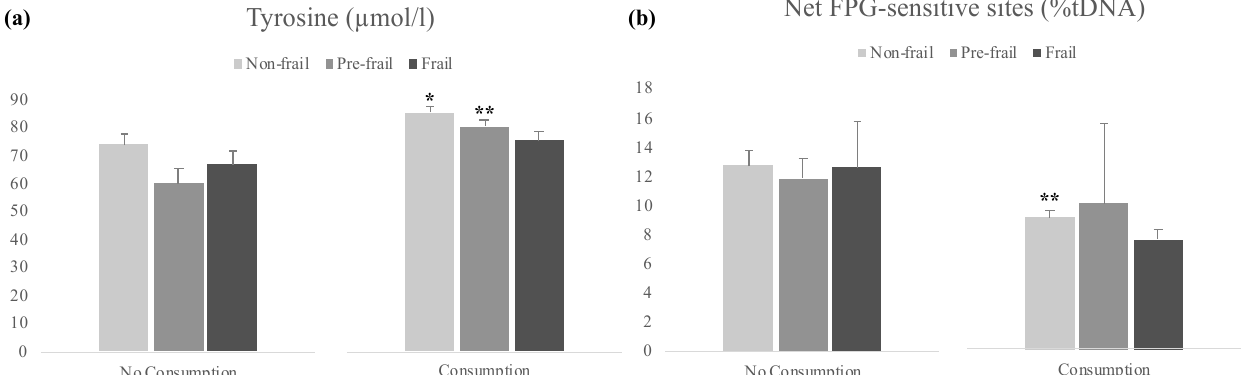
Figure 3. Results of Tyrosine ( a ) and Net FPG-sensitive sites ( b ) by study groups, classified according to fruit/vegetables consumption and frailty status. Bars represent mean ± standard error. * p < 0.05, ** p < 0.01, significant difference with regard to no consumption within the same frailty group (Student’s t -test).